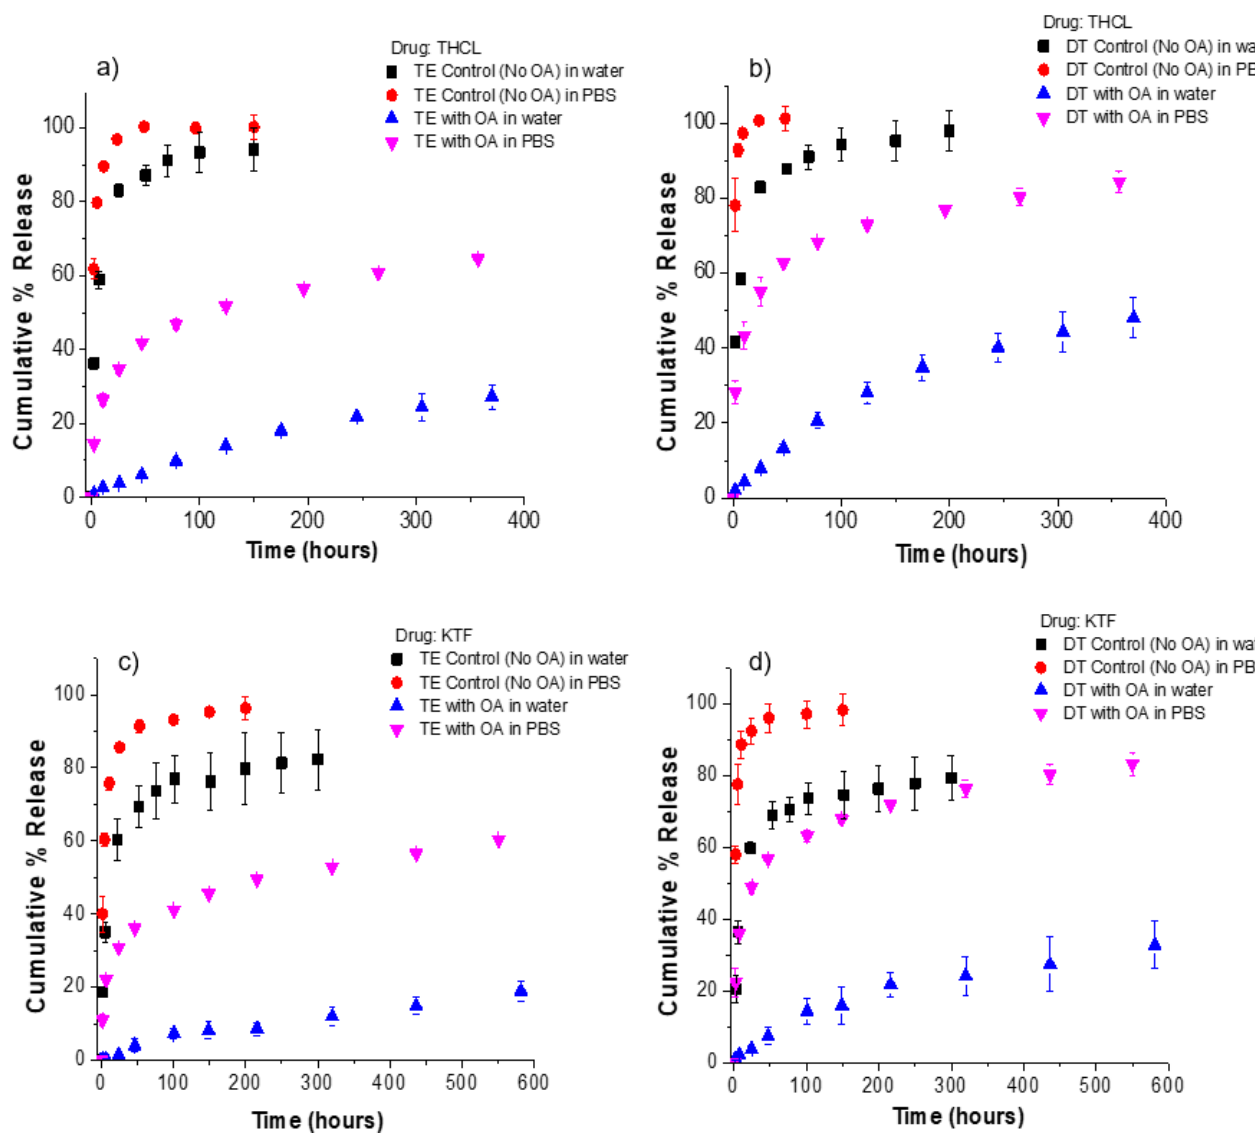
Figure 5. Release kinetics of KTF and THCL from unmodified and oleic acid loaded ACUVUE TruEye ® and Dailies Total1 ® in deionized water or 1X PBS. Oleic acid was loaded at a fixed soaking concentration of 50 mM for all cases. ( a ) THCL cumulative % release from ACUVUE TruEye ® . The total amount of drug uptake: 120.3 ± 4.0 µg for control lenses and 539.6 ± 3.0 µg for OA lenses. ( b ) THCL cumulative % release from Dailies Total1 ® . The total amount of drug uptake: 99.4 ± 1.7 µg for control lenses and 360.8 ± 13.4 µg for OA lenses. ( c ) KTF cumulative % release from ACUVUE TruEye ® . The total amount of drug uptake: 211.1 ± 13.0 µg for control lenses and 802.3 ± 7.0 µg for OA lenses. ( d ) KTF cumulative % release from Dailies Total1 ® . The total amount of drug uptake: 152.8 ± 7.1 µg for control lenses and 516.8 ± 70.6 µg for OA lenses. Data are presented as mean +/- standard deviation with n = 3.